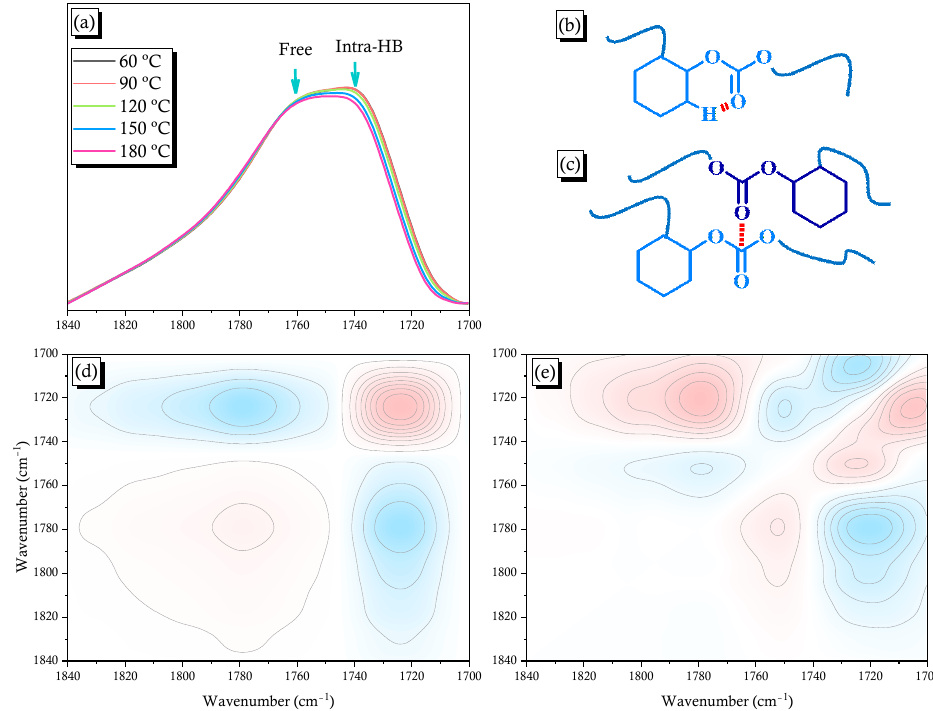
Figure 2. ( a ) FTIR spectra of the pure PCHC copolymer, recorded at various temperatures; ( b ) Schematic representation of the intramolecular [C–H ··· O=C] H-bonding; ( c ) Schematic representation of the free C=O units undergoing dipole–dipole interactions; ( d , e ) 2D FTIR spectral ( d ) synchronous and ( e ) asynchronous correlation maps.